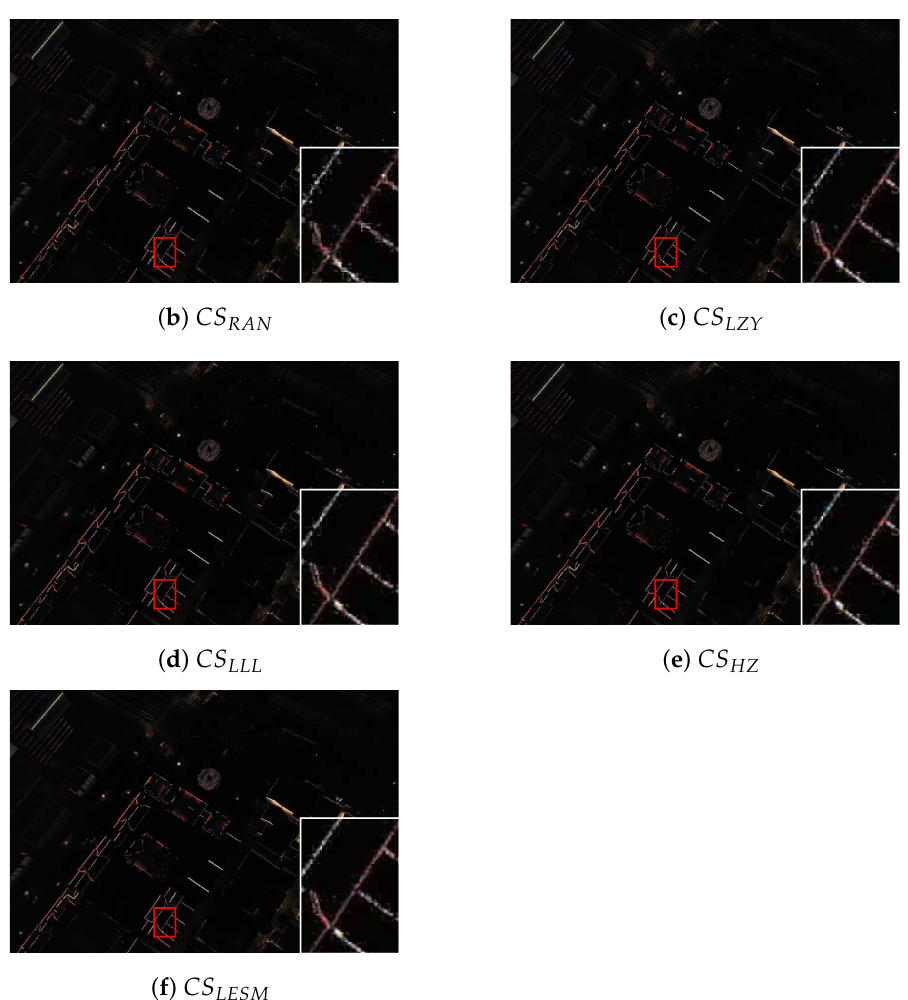
Figure 7. Recovery results for the UAV image "night view" taken by ourselves with noise ( SNR = 10 dB). ( a ) is the original image, ( a1 ) is the image with noise, ( b ) is the CS RAN algorithm, ( c ) is the CS LZY algorithm, ( d ) is the CS LLL algorithm, ( e ) is the CS HZ algorithm, and ( f ) is the CS LESM algorithm.